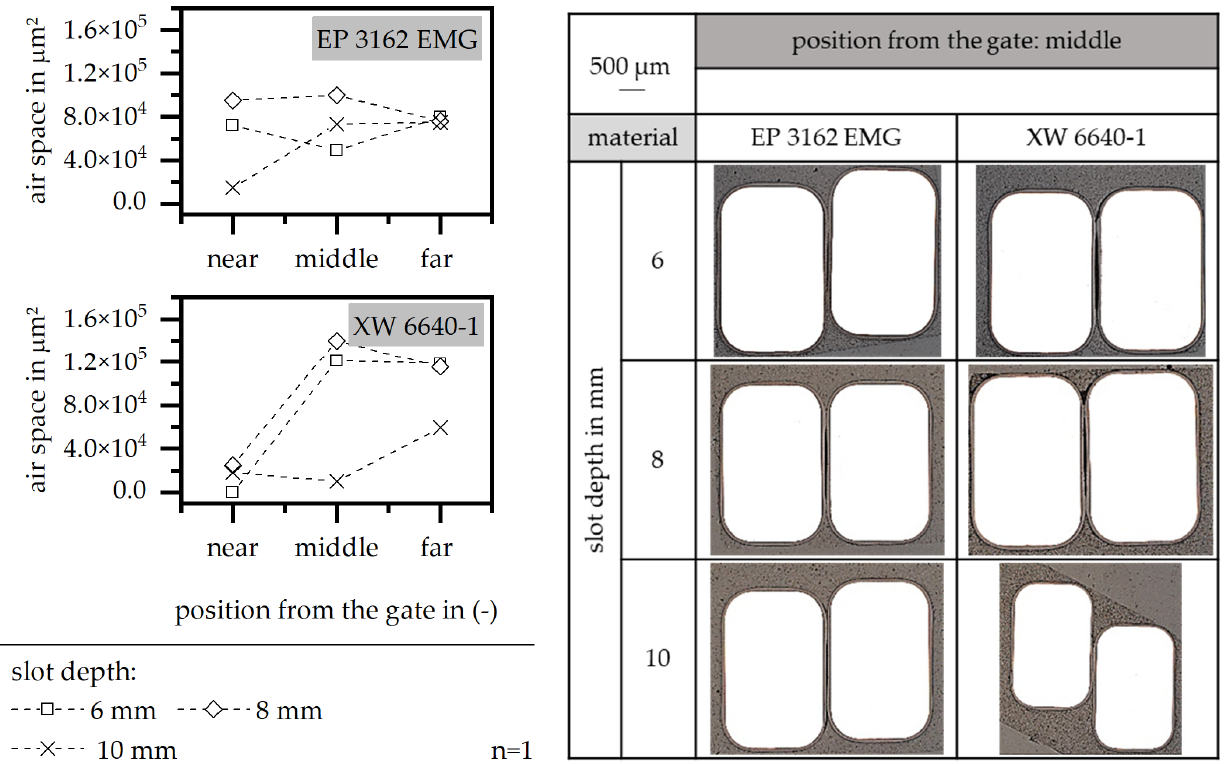
Figure 15. Airspace and position of the wire relative to the stack, relative to the slot depth in the insulation system.